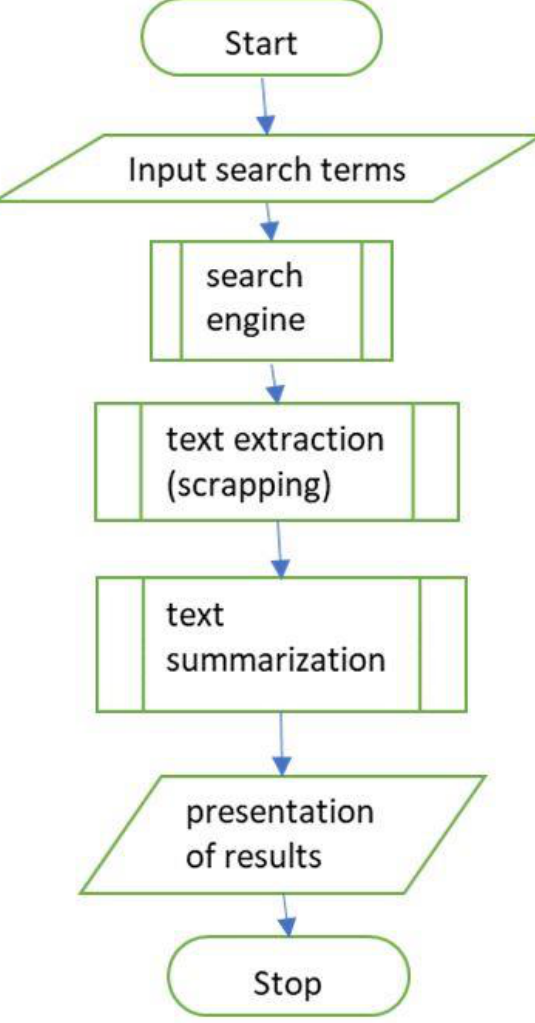
Figure 2. Flow chart diagram of the basic tool chain suggested.